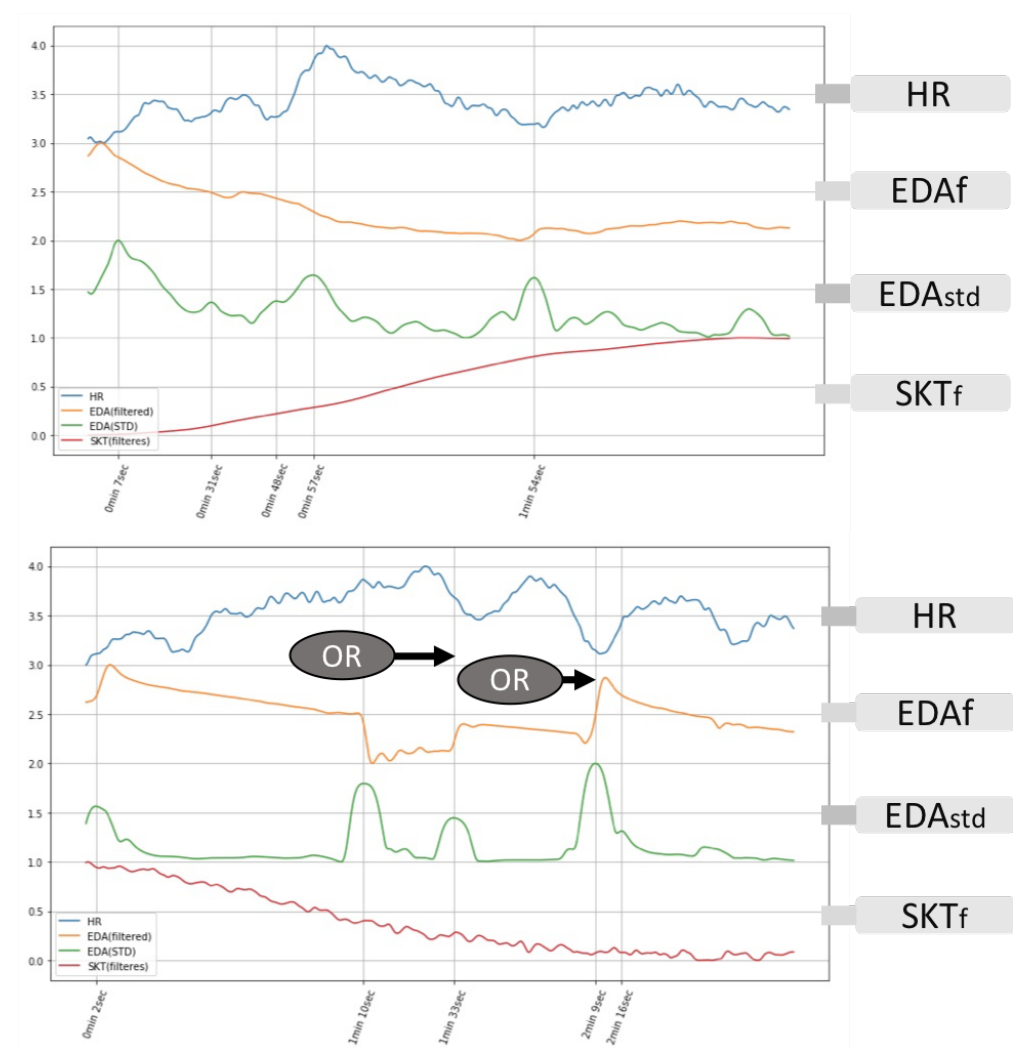
Figure 4. Orienting responses on unsuccessful (upper) and successful (lower) emotion elicitation of film